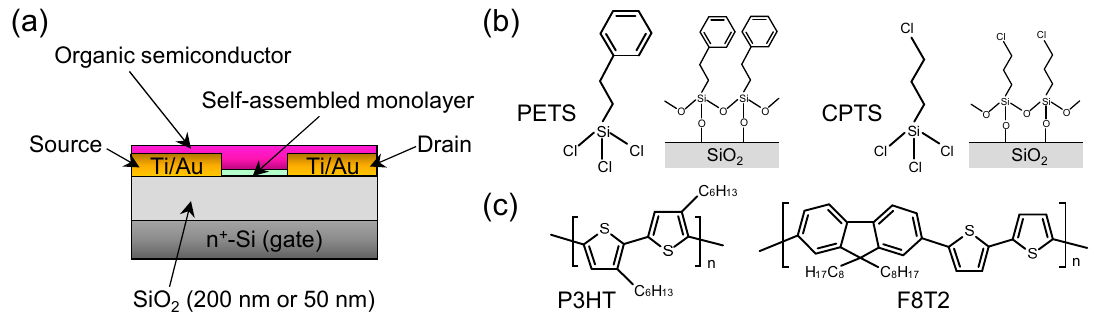
Figure 1. ( a ) Schematic cross-section of short-channel organic field-effect transistors (OFETs) fabricated in this study. Chemical structures of ( b ) organosilanes and ( c ) polymer semiconductors; PETS: phenethyltrichlorosilane; CPTS: 3-chloropropyltrichlorosilane; P3HT: poly(3-hexylthiophene); F8T2: poly(9,9-dioctylfluorene-co-bithiophene).